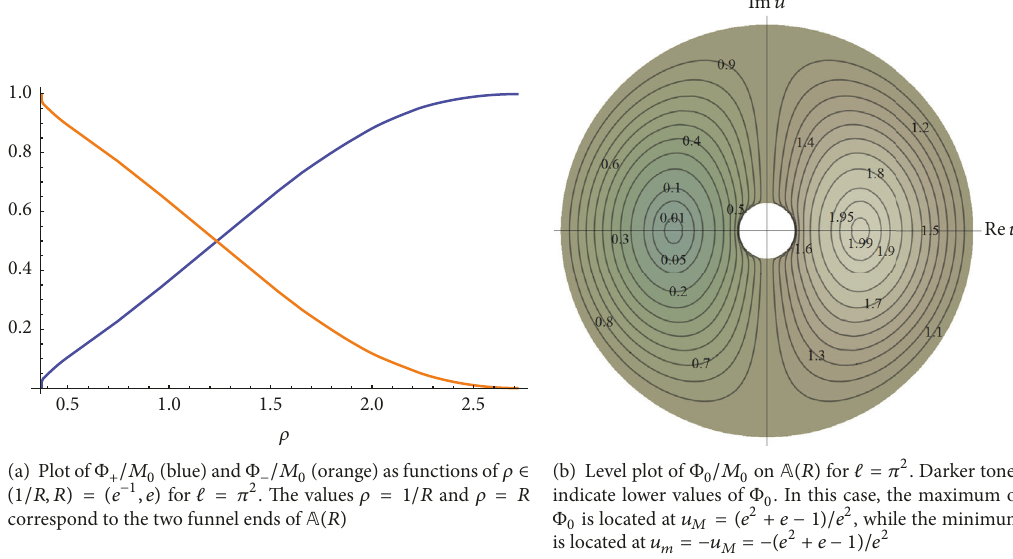
Figure 16: The potentials Φ ± and Φ 0 on the annulus of modulus 𝜇 = 2 ( ℓ = 𝜋 2 , 𝑅 = 𝑒 ). For Φ + and Φ − , we indicate only the dependence of 𝜌 = |𝑢| , since these two potentials do not depend on the polar angle 𝜃 . Notice that Φ tends to its infimum at the outer funnel end. Similarly, Φ + and Φ − tend to their suprema at opposite funnel